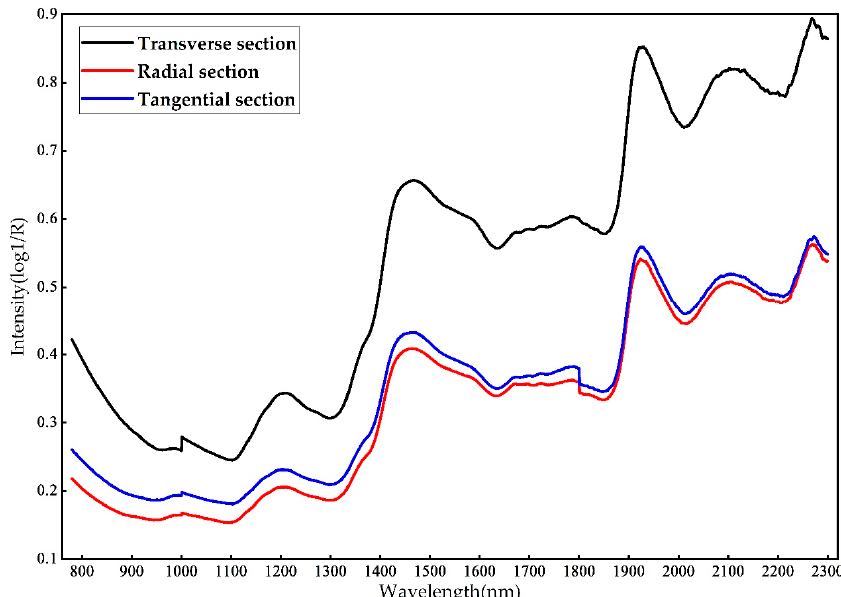
Figure 3. Raw NIR spectra of the three different sections of Dipteryx sp. wood.